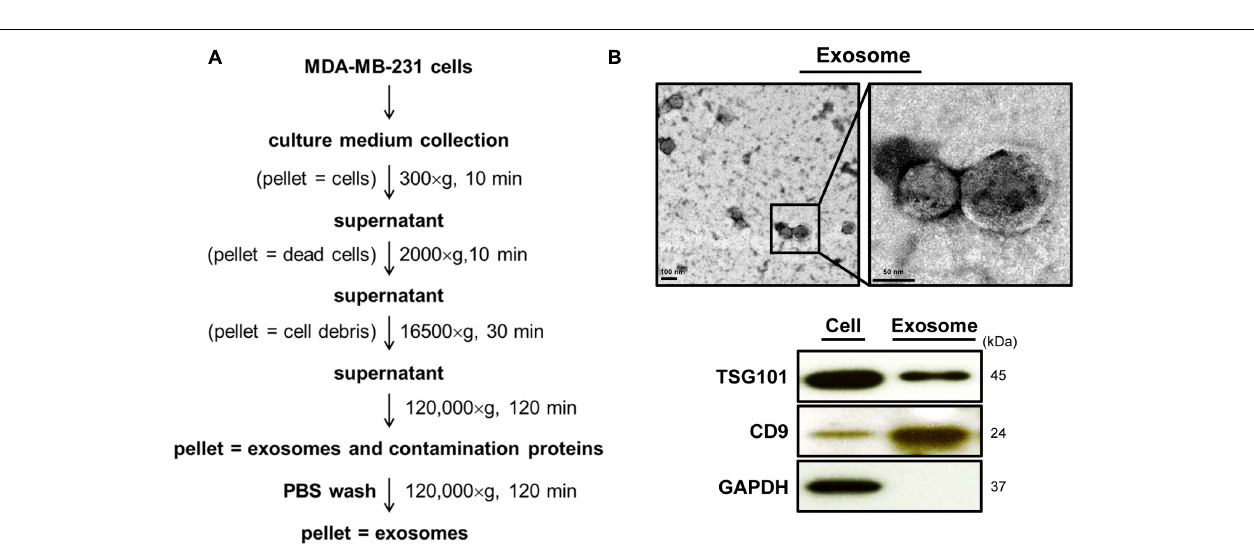
FIGURE 2 | Deoxyelephantopin and DETD-35 induced the calcium ion levels in TNBC cells. (A) MDA-MB-231 cells were treated with vehicle (0.5% DMSO), DET (11 µ M), or DETD-35 (3 µ M) for 2 h. In parallel, TNBC cells were treated with ionomycin (4 µ M) for 5 min as a positive control. Cytosolic free calcium level was determined with Fluo-4 Ca 2 + fluorescent dye in the treated cells using flow cytometry. (B) MDA-MB-231 cells were pre-treated with 20 µ M calcium chelator BAPTA-AM for 30 min, and then treated with vehicle or both compounds for 2 h. Detection of cytosolic free calcium level in the treated cells used flow cytometry.